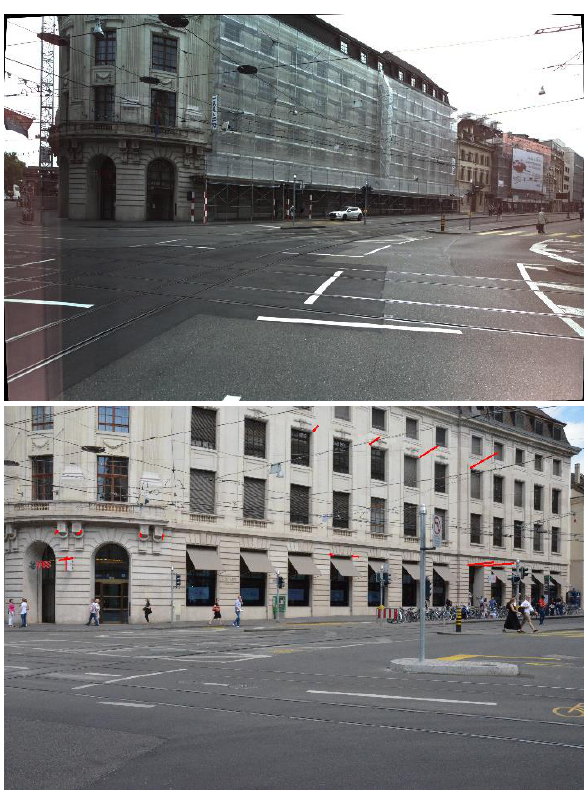
Figure 5. Example of a successfully oriented image (bottom) overlaid with residuals of reprojection (scaled 5x). This picture could be aligned, even though in the reference images an entire building façade was covered by scaffolding (top).